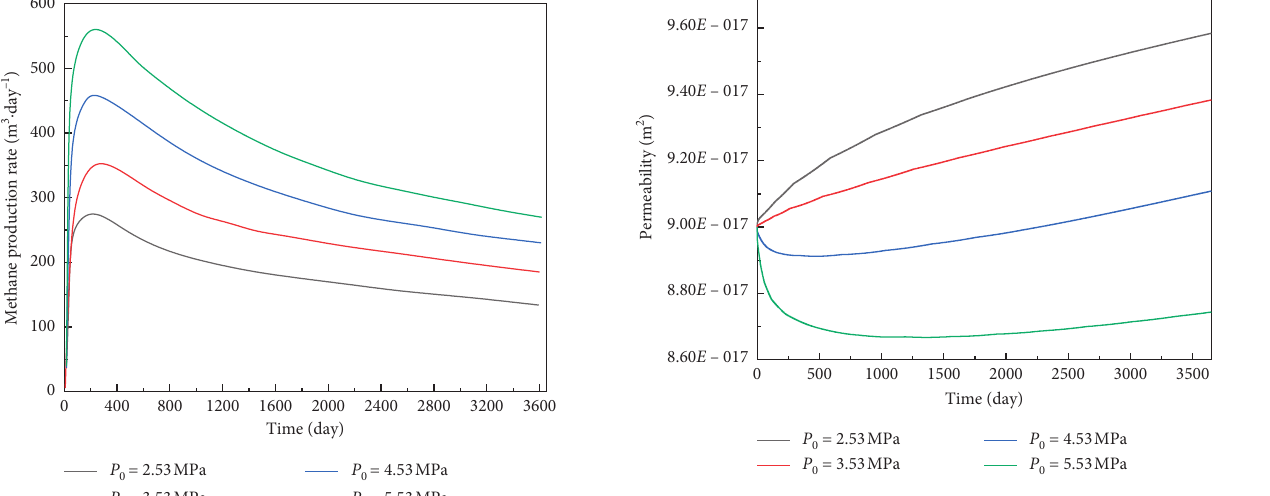
Figure 7: Variation of coalbed permeability with different initial coalbed pressure at the reference point